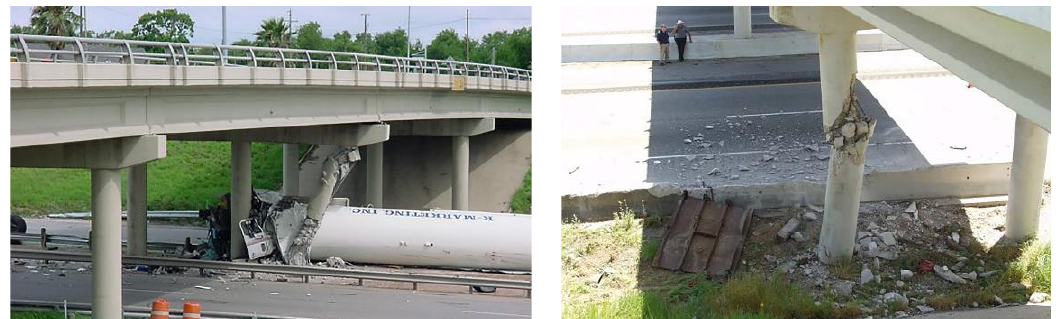
Figure 1. Bridge pier under vehicle collision [1].